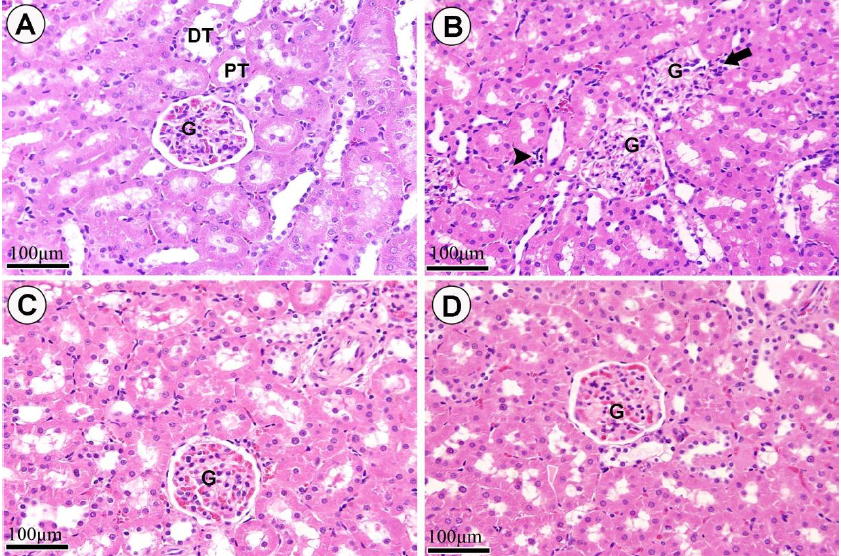
Figure 7. Light micrographs of renal cortex of STZ induced diabetic rats treated with two doses of L. regularis (150 and 300 mg/kg/day). Section from the renal cortex of the control group shows the normal architecture of the proximal convoluted tubules (PT), distal convoluted tubules (DT), Bowman's capsule and glomerulus (G) ( A ). Renal cortex of untreated dia- betic animals showed vacuolar degeneration, signs of necrosis (head arrow), narrowed glomerular (G) and mononuclear cells infiltration were observed (arrow) ( B ). Renal cortex of diabetic animals co-treated with 150 mg/kg/day ( C ) and 300 mg/kg/day ( D ) of L. regularis remediated the adverse effects of STZ on kidneys in glomeruli and renal tubules. (H&E, Scale bar,